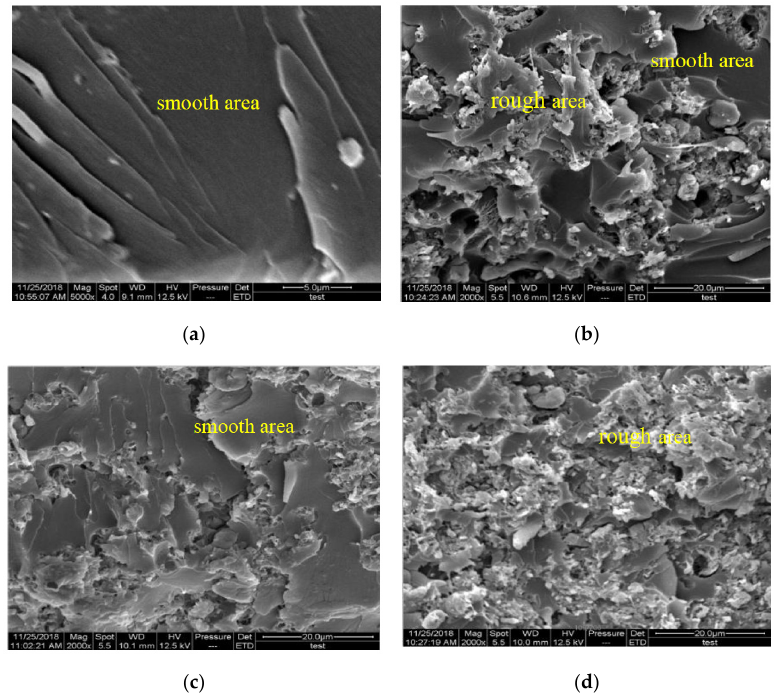
Figure 3. SEM images of section morphology of different coatings. ( a ) Unmixed epoxy, ( b ) epoxy-PTFE, ( c ) epoxy-PTFE/TiO 2 (unmodify), ( d ) epoxy-PTFE/TiO 2 (modify).